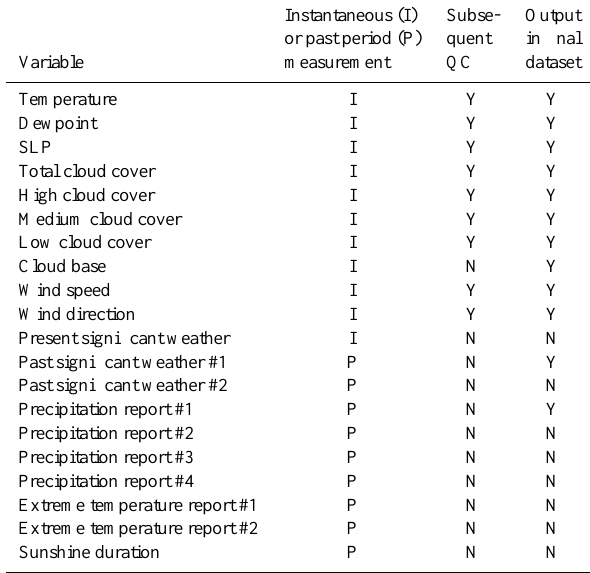
Table 2. Variables extracted from the ISD database and converted to netCDF for subsequent potential analysis. The second column indicates whether the value is an instantaneous measure or a time- averaged quantity. The third column shows the subset that we qual- ity controlled and the fourth column the set included within the final files which includes some non-quality controlled